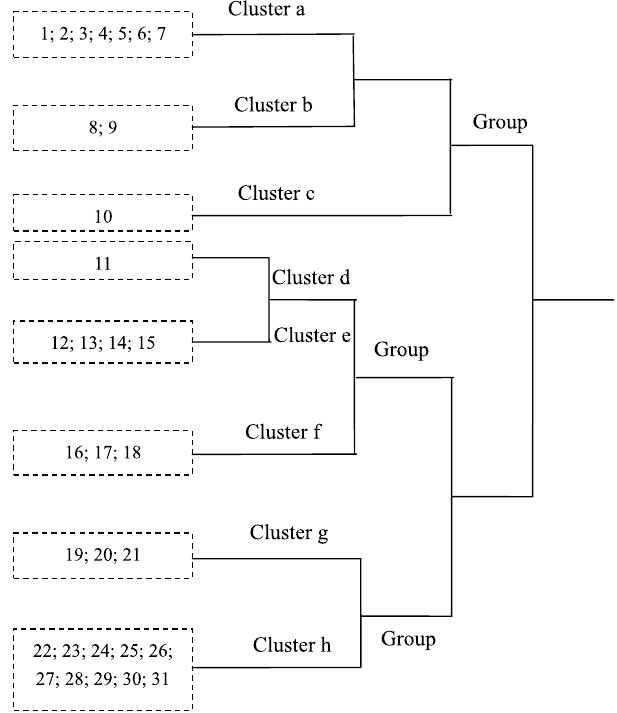
Figure 6. Results of TWINSPAN for the data from the plots in S2. Note: Species abbreviations are 1: Cosmos bipinnata Cav.; 2: Heteropappus altaicus (Willd) Novopokr; 3: Caragana Korshinskii Kom; 4: Neotorularia humilis (C. A. Meyer) Hedge & J. Léonard; 5: Gueldenstaedtia verna (Georgi) Boriss.; 6: Polygala wattersii Hance; 7: Convolvulus ammannii Desr.; 8: Suaeda glauca (Bunge) Bunge; 9: Potentilla bifurca L., 10: Leontopodium leontopodioides (Willd.) Beauv.; 11: Lespedeza davurica (Laxm.) Schindl., 12: Allium mongolicum Regel.; 13: Setaria viridis (L.) Beauv.; 14: Limonium bicolor (Bunge) Kuntze; 15: Pseudognaphalium affine (D. Don) Anderberg; 16: Stenosolenium saxatile (Pallas) Turczaninow; 17: Corispermum mongolicum Iljin; 18: Hyoscyamus niger L.; 19: Gueldenstaedtia stenophylla Bunge; 20: Caragana brachypoda Pojark.; 21: Artemisia frigida Willd.; 22: Digitaria sanguinalis (L.) Scop.; 23: Stipa tianschanica Roshev. var. gobica (Roshev.) P.C.Kuo et Y.H.Sun; 24: Artemisia capillaris Thunb.; 25: Peganum harmala L.; 26: Astragalus discolor Bunge ex Maxim. in Bull.; 27: Tribulus terrester L.; 28: Cleistogenes squarrosa (Trin.) Keng; 29: Achnatherum splendens (Trin.) Nevski; 30: Cleistogenes caespitosa Keng; 31: Euphorbia humifusa Willd. Group 1 to Group 3 would be confirmed in the next step. Therefore, G1 to G3 were not labeled in this